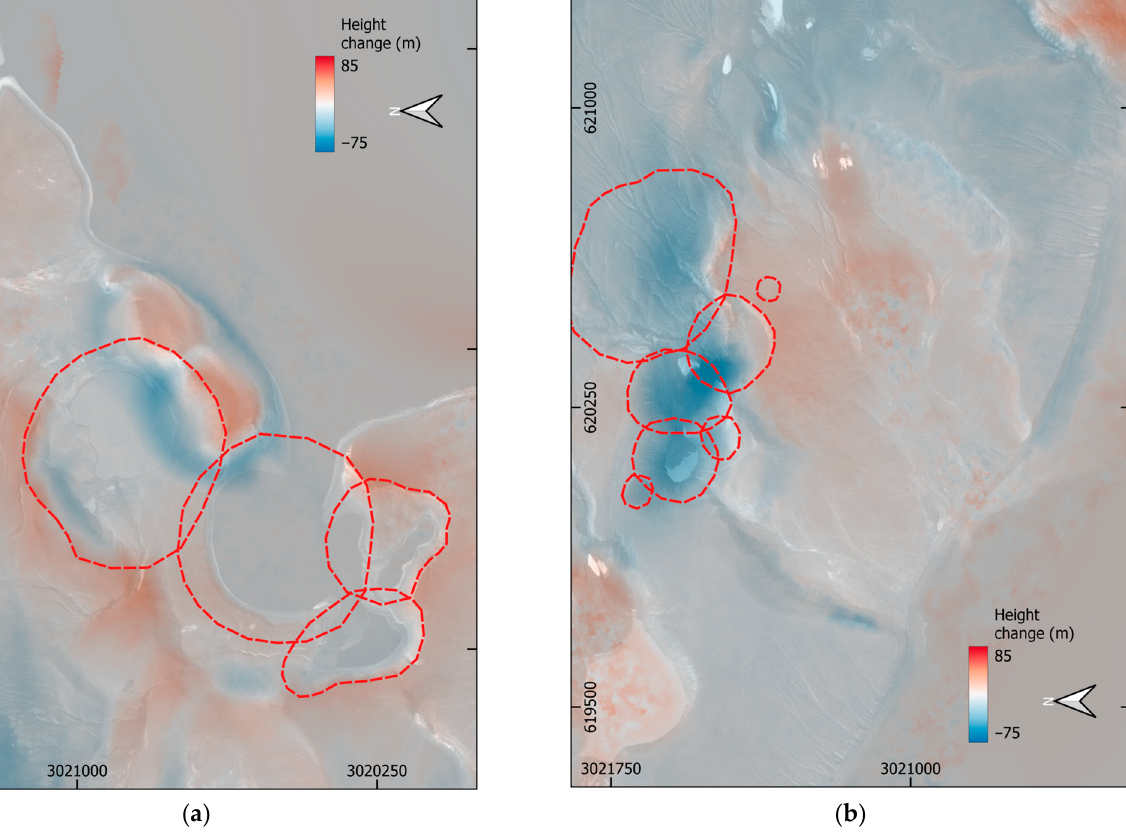
Figure 10. The composition of the 2020 orthographic mosaic in black and white overlapped with 30% transparency to the height differences between the 1968 and REMA digital elevation models in colour from WGS84–UTM20S, and red dashed lines delimiting main volcanic structures. ( a ) The collapse of the northwest face of the 1967 scoria cones and its annexation and maar craters. ( b ) The set of craters formed in 1970, one of which with a depth of about 85 m and a crater diameter of 300 m covered by an alluvial fan.